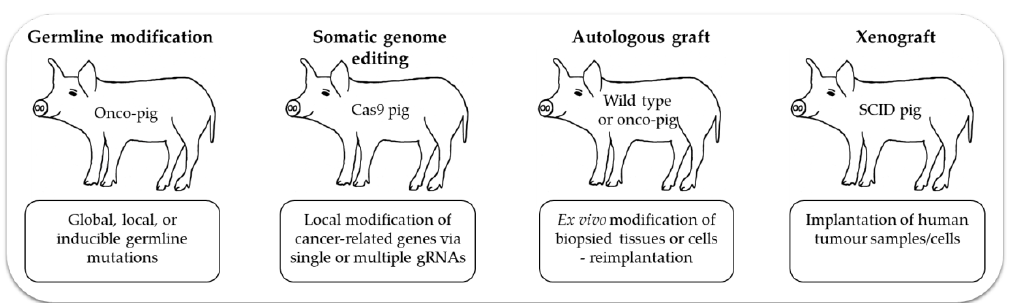
Figure 3. Porcine cancer models. These can be established by different methods: e.g., introduction of oncogenic germline mutations or via genome editing in organs of a Cas9 pig. Biopsies taken early in life can be oncogenically transformed and reimplanted into the same pig. If isolated from a pig with latent oncogenic mutations, these can be activated in vitro prior to implantation. Human tumor samples can also be implanted in immune deficient animals.